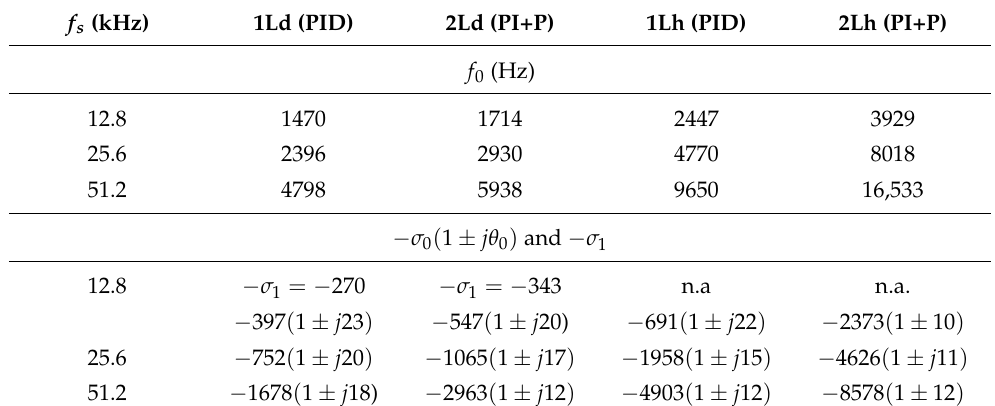
Figure 23. Comparison of ( a ) 2Lh (PI+P) with ( b ) 1Lh (PID) and ( c ) 2Ld (PI+P) with ( d ) 1Ld (PID) at f s = 25.6 kHz. Comparison of hybrid and digital systems is also possible. The dominant roots are shown by arrows. Table 5. Dominant roots in various control structures and their parameters: f 0 , σ , and θ